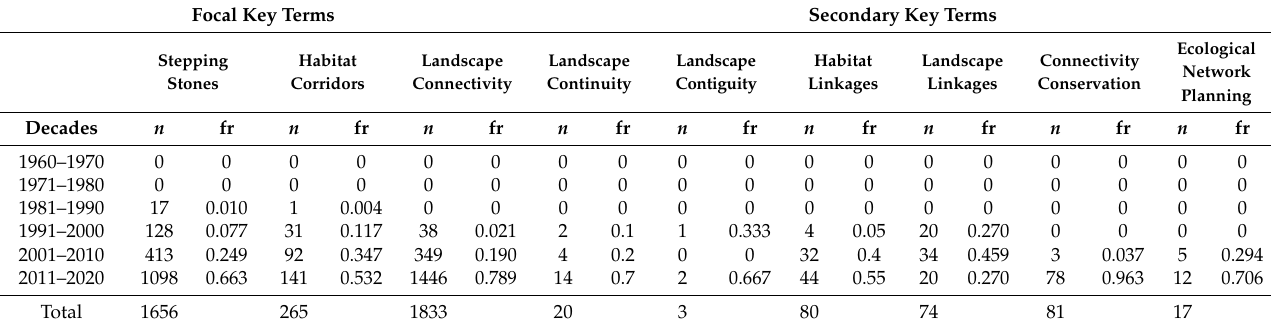
Table 1. Recurrences of habitat fragmentation-related (focal and secondary) terms in Web of Science in the time range 1960–2020 ( n : number of recurrences and fr: relative